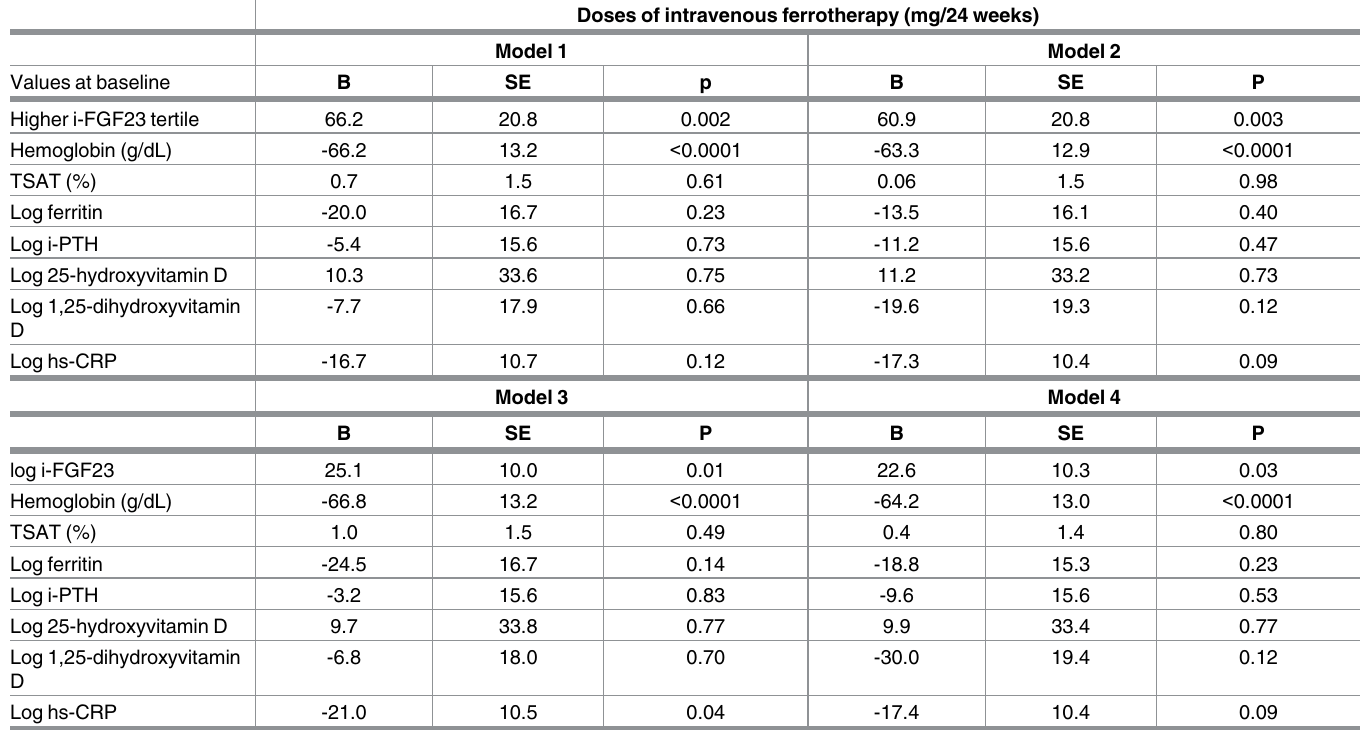
Table 4. Association of intact fibroblast growth factor 23 levels with doses of intravenous ferrotherapy over 24 weeks. Doses of intravenous ferrotherapy (mg/24